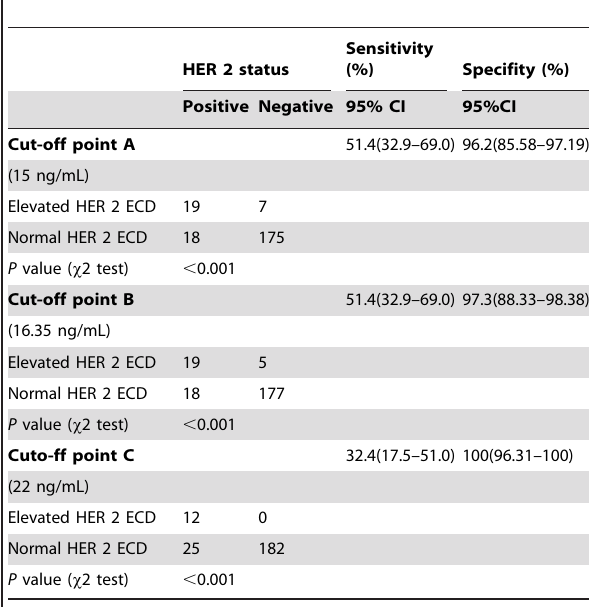
Figure 3. ROC curve for selection of the best cut-off value of serum HER 2 ECD to predict tissue HER 2 status. A cut-off of 16.35 ng/mL has a sensitivity of 51.4% and a specificity of 97.3% in discriminating HER 2-positive and HER 2-negative tumours.